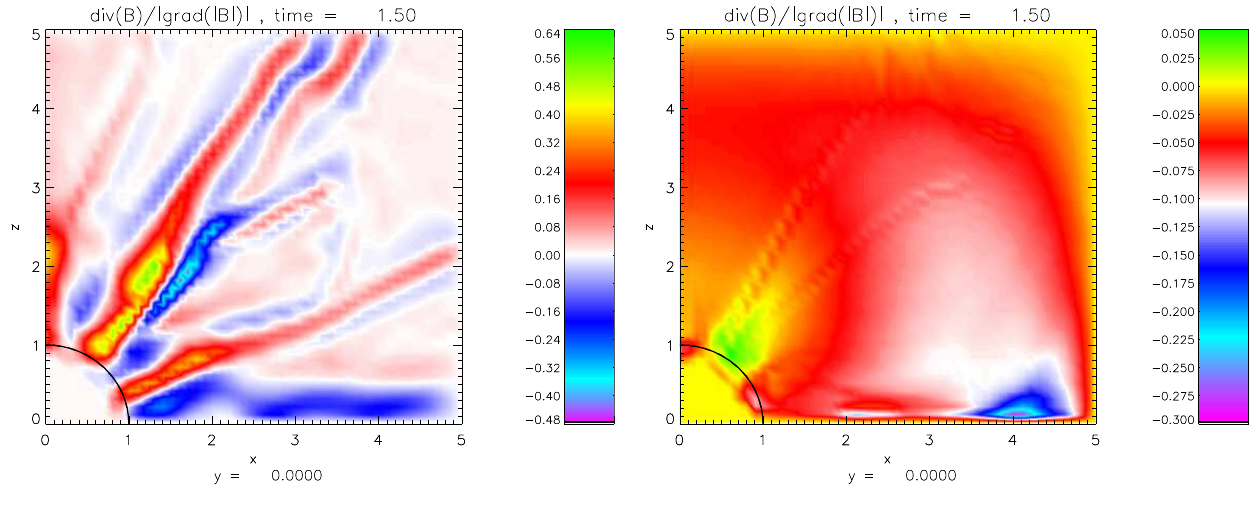
√ B · B k in the (poloidal) (x,z) plane for a standard solar wind run at time t = 1 . 5 without Fig. 3. Normalized divergence error κ := ( ∇· B )/ k∇ correction (left) and using GLM (right). The improvement is substantial but still insufficient due to massive divergence values introduced at the inner boundary (unit circle around the origin). The projection scheme achieves κ ∼ 10 − 6 (not shown). Note the different color